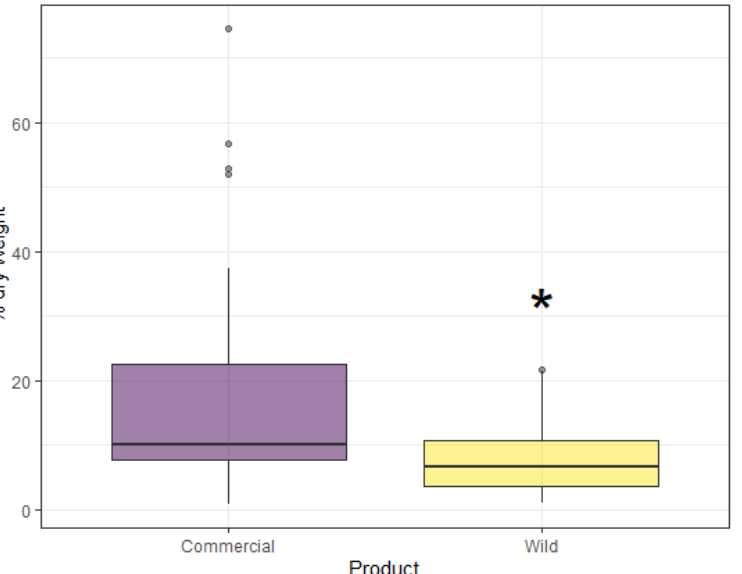
Figure 2. Total lipid (TL) content (% dry weight) in muscle tissue from the wild and commercial samples of beaked redfish Sebastes mentella . Note: *—significantly ( p ≤ 0.05) different between wild and commercial product.